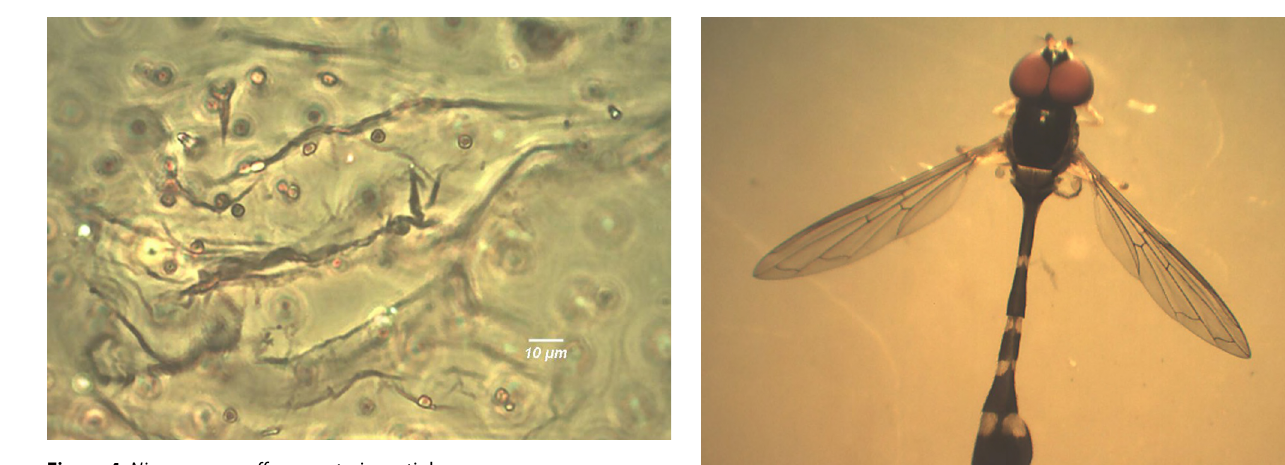
Figure 4. Nipaecoccus coffeae : posterior